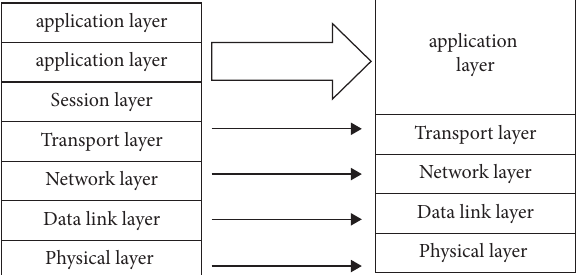
Figure 1: Research network model of the wireless sensor